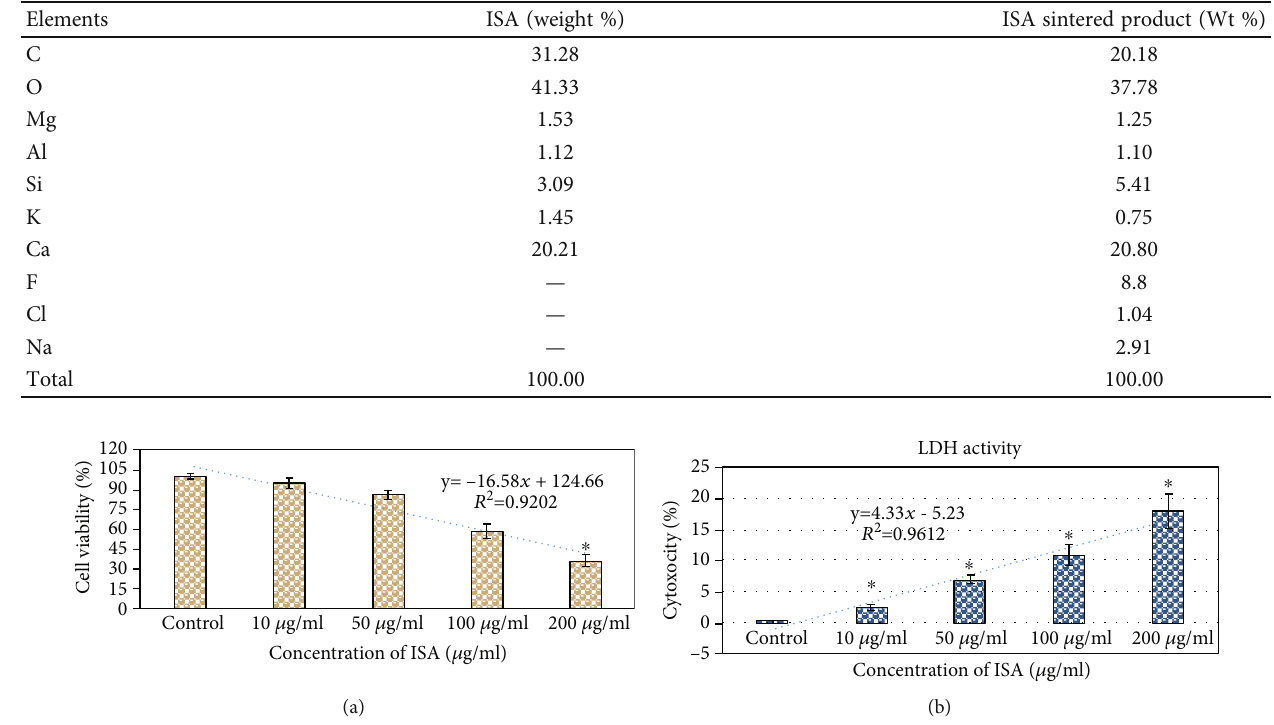
Figure 6: Cytotoxicity of ISA on the RTG-2 cell line for 24 h. (a) MTT assay and (b) LDH assay. Each value represents the average ± SE of three experiments. n = 3 , ∗ p < 0 : 5 versus control.